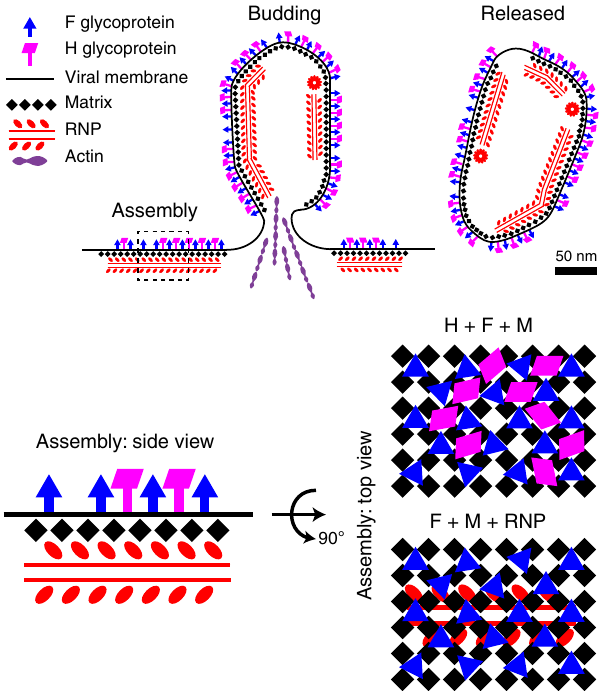
Fig. 6 MeV assembly model. At the assembly site, viral components, including glycoproteins F and H, matrix protein (M), and RNP complexes, accumulate at the plasma membrane to initiate the assembly process. Actin fi laments are potentially involved during the process. At the assembly site, M is the driving force which orchestrates the whole process by interacting with F and RNPs in a timely and spatially organized manner: M forms a 2D lattice under the envelope, F forms another 2D lattice interspersed above the M lattice, and RNP complexes lie under the M lattice with some degree of fl exibility. H is incorporated at sites of assembly but does not appear with high spatial ordering. Once assembled, viral particles undergo an unknown scission event and bud off the plasma membrane. After release, the viral particles are free to infect the next